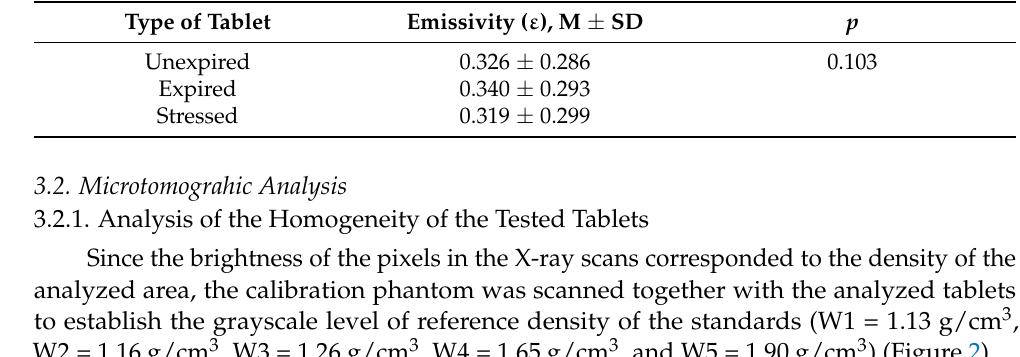
Table 3. The emissivity of the analyzed tablets containing nifuroxazide.